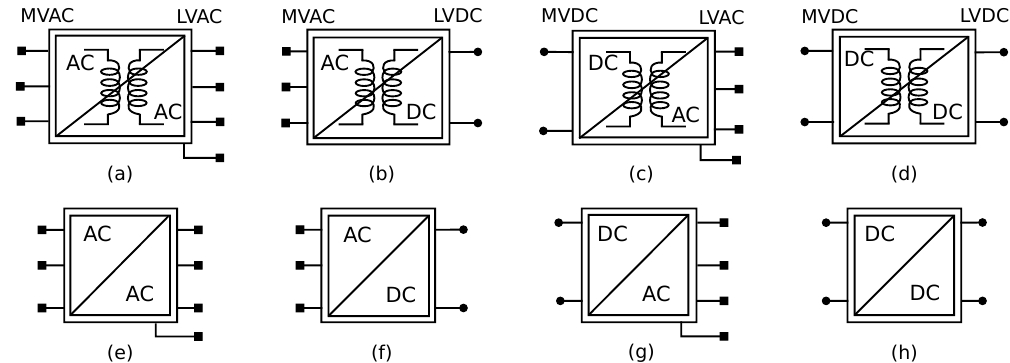
Figure 2. Single input single output (SISO) building blocks for formation of SST: ( a – d ) isolated power